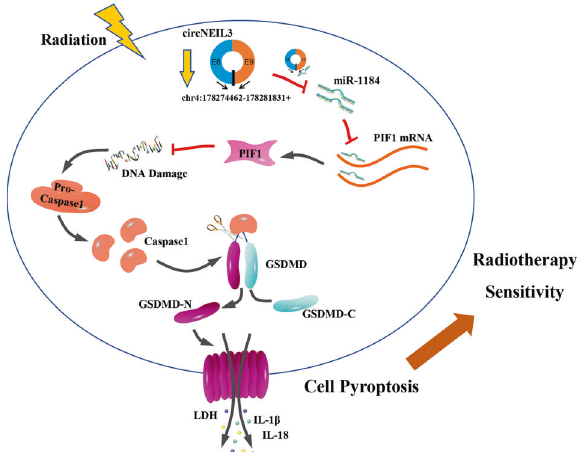
Fig. 8 Diagram of the proposed mechanism and function of circNEIL3 in lung adenocarcinoma radiotherapy. circNEIL3 exerts its function as a ceRNA by directly binding to miR-1184, thereby abrogating the endogenous inhibitory effect of miR-1184 on the target gene PIF1, and inducing signi fi cant DNA damage, which in turn triggers AIM2 in fl ammasome activation to induce pyroptosis, ultimately affecting survival in lung cancer